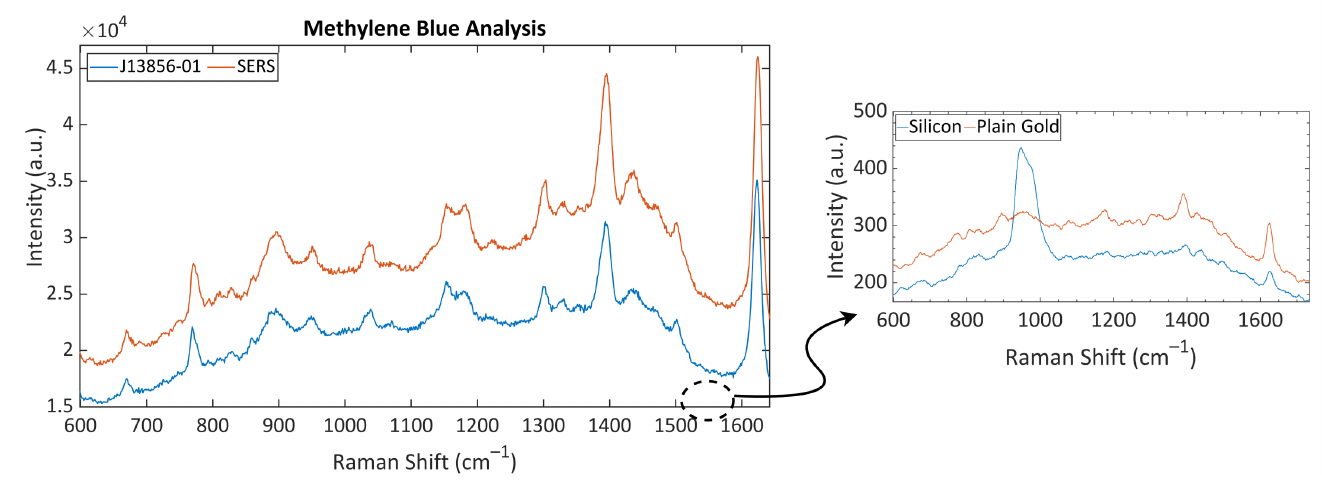
Figure 6. Raman spectra of methylene blue (MB) collected from the silicon, the plain gold, the industrial, and the optimized SERS substrates. The characteristic peaks of MB were detected in the spectrum collected from the optimized SERS substrate with a good SNR, comparable to the industrial SERS substrate J13856-01. Table 1. The obtained Raman spectra and attributed chemical structures (s, strong; m, medium; w, weak peak intensity). Each of the spectra and peaks were measured 30 times and were reproducible. The reproducibility of the spectra precludes any potential destructive effects of thermal drift due to enhanced localization.